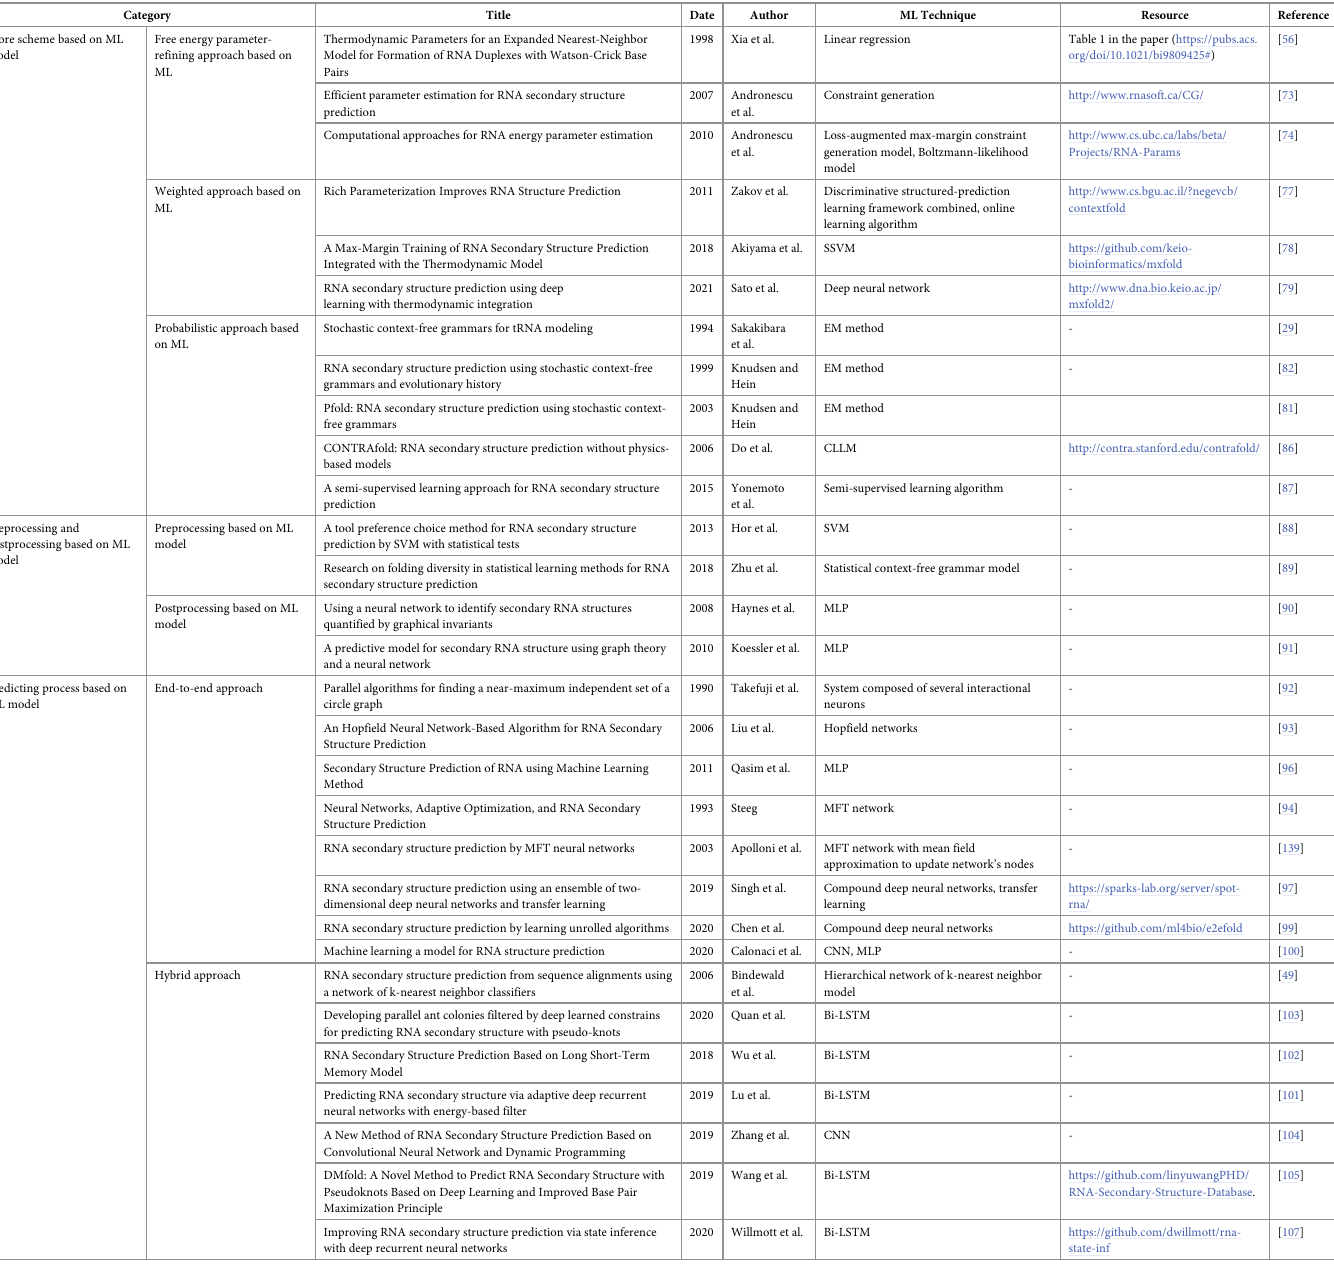
Table 1. Summary of the ML-based RNA secondary structure prediction methods.